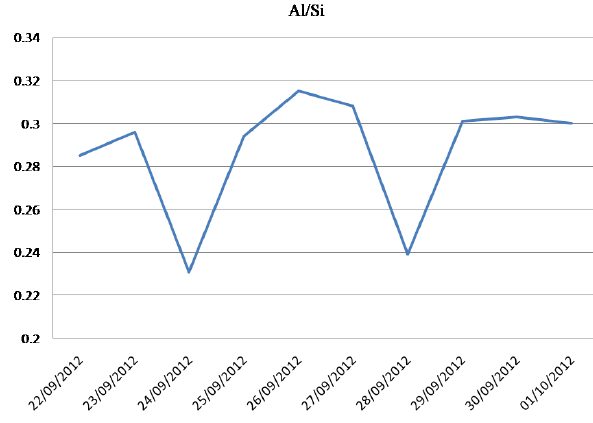
Figure 9. Al / Si ratio